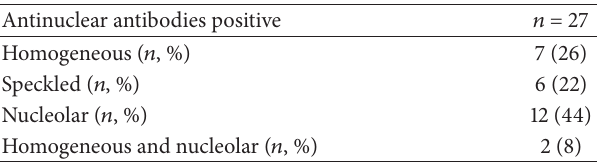
Table 2: IF pattern of antinuclear antibodies.